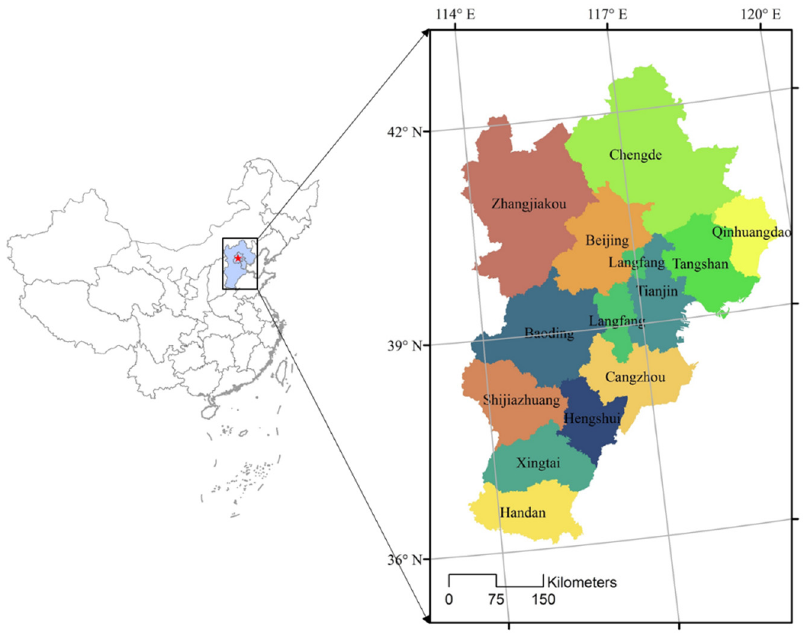
Figure 1. Geographical location of the Beijing–Tianjin–Hebei region.